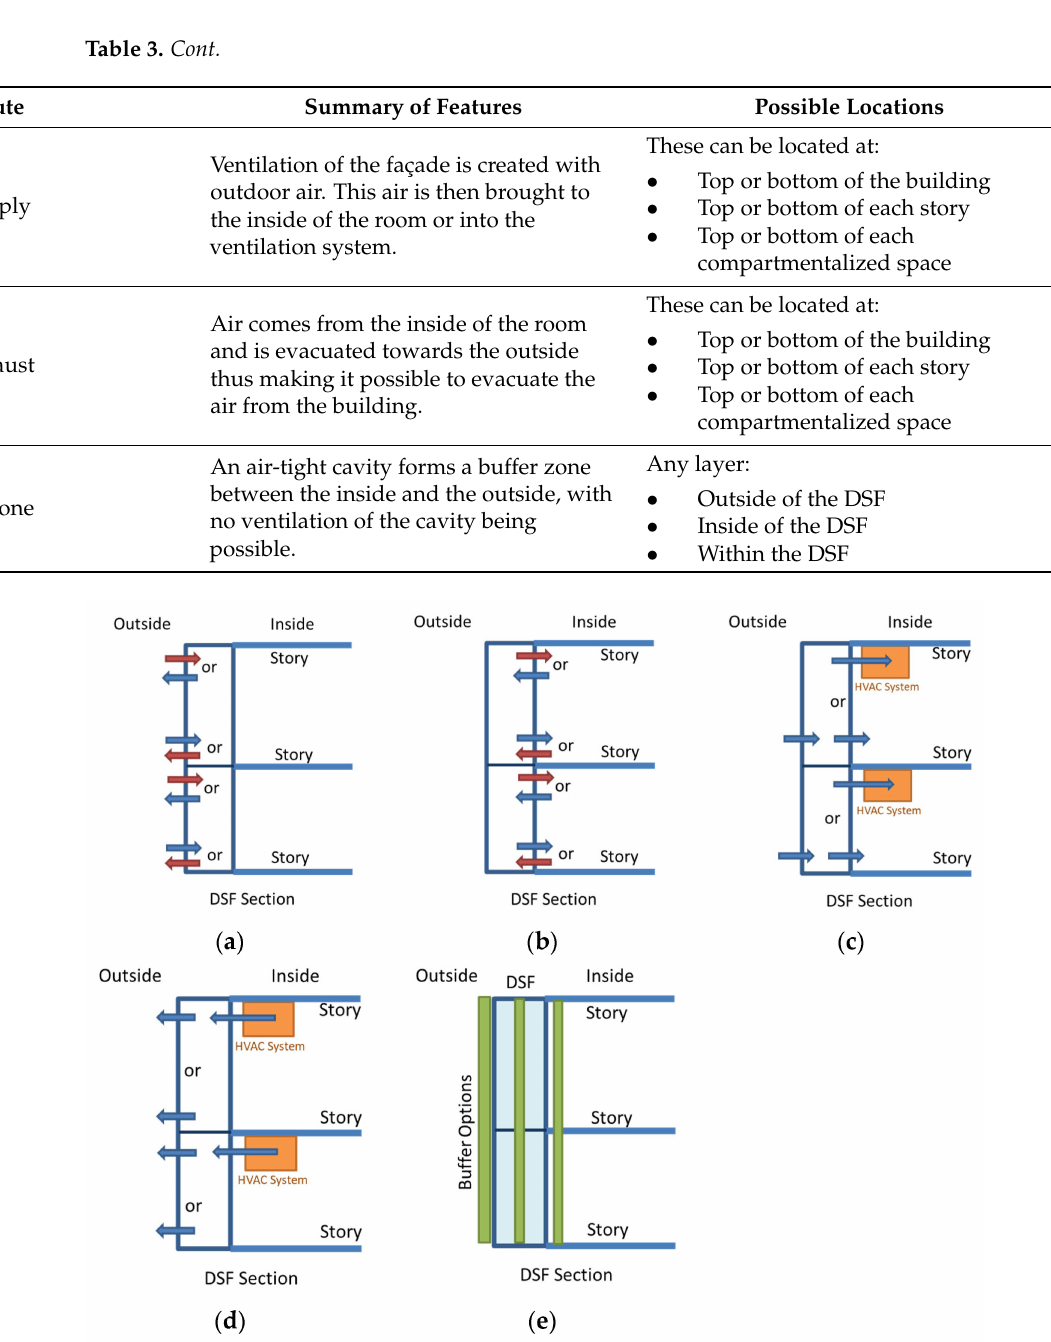
Figure 2. Representative DSF Ventilation Configurations: ( a ) Outdoor Air Curtain Configuration; ( b ) Indoor Air Curtain Configuration; ( c ) Air Supply Configuration; ( d ) Air Exhaust Configuration; ( e ) Buffer Zone